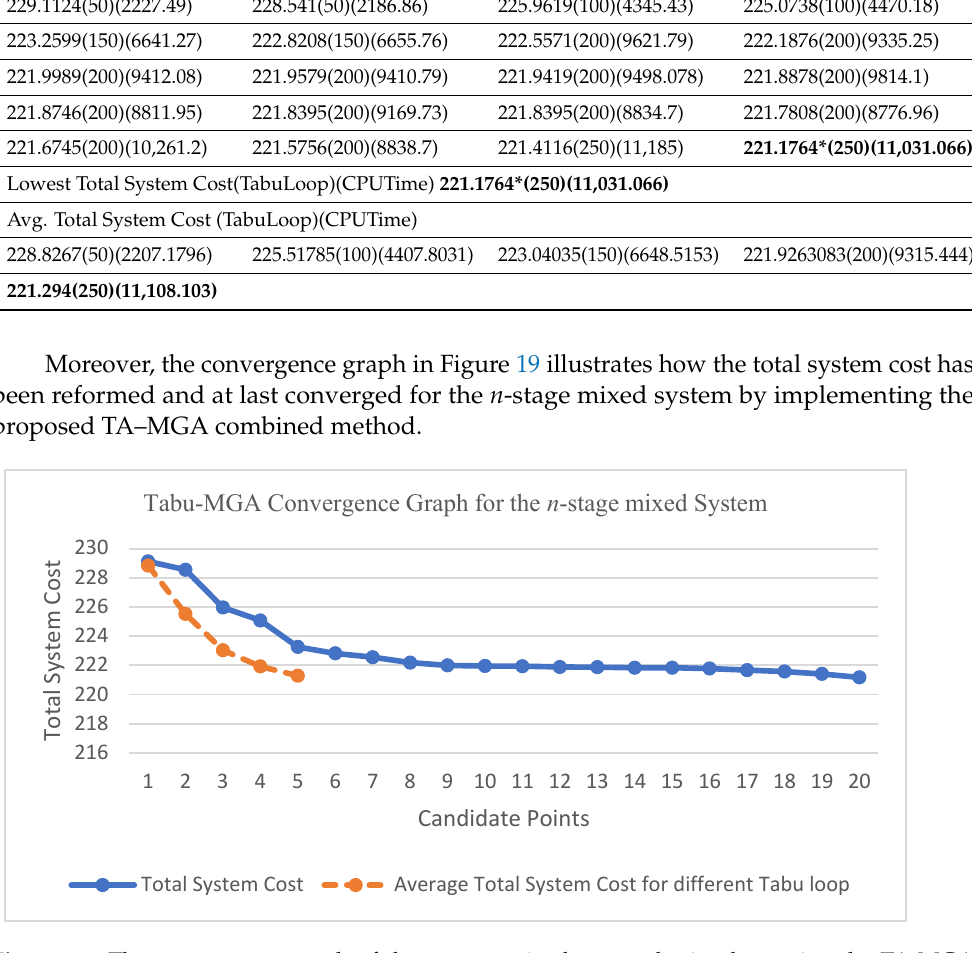
Figure 19. The convergence graph of the n -stage mixed system by implementing the TA-MGA combined method.